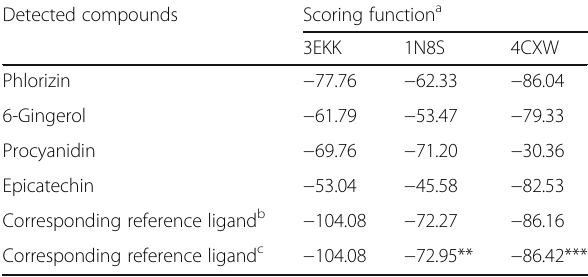
Table 1 Comparison of docking affinity of the test molecules with the ligand based cocrystallized site of the targeted proteins Detected compounds Scoring function